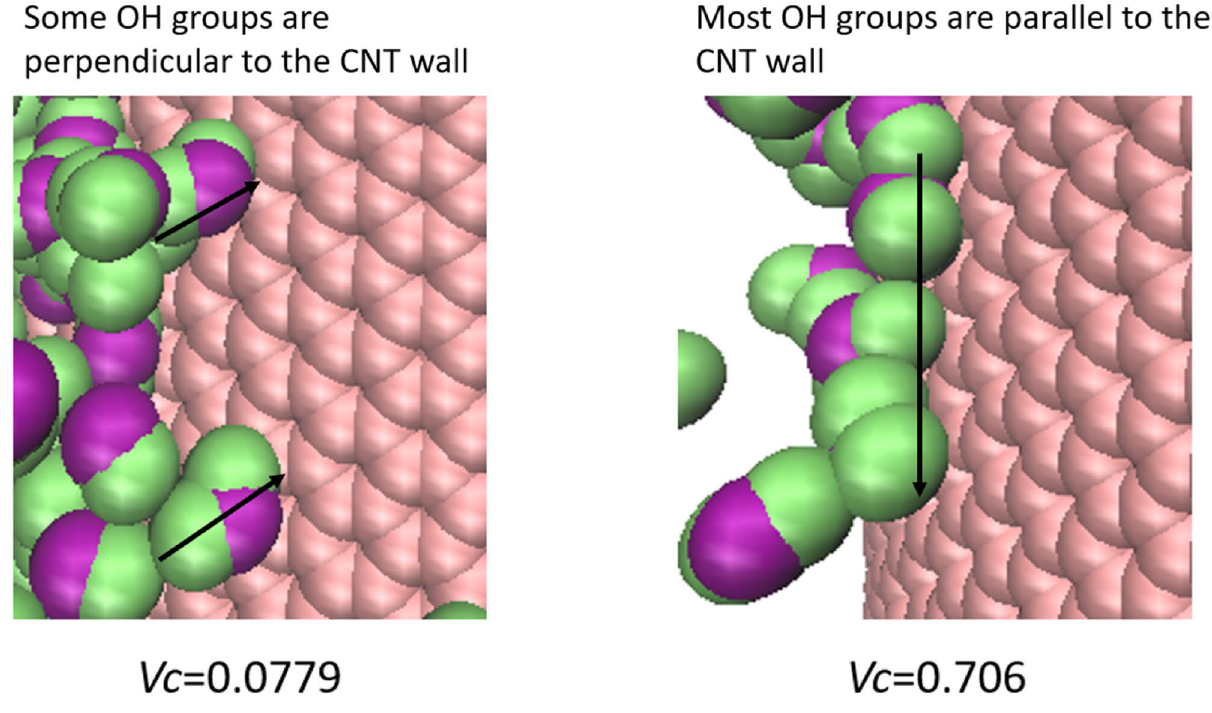
Figure 7. Comparison of OH groups facing the CNT wall.